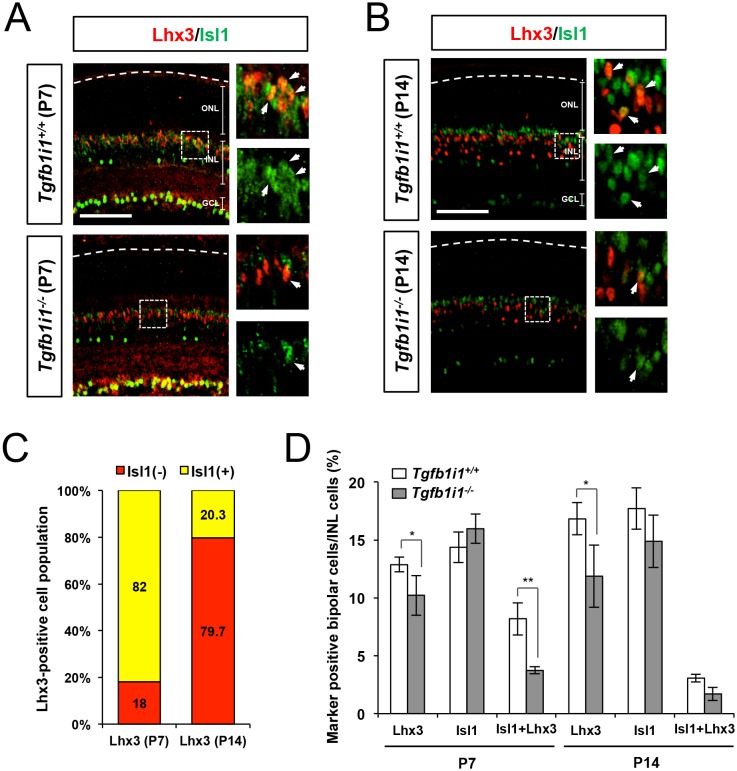
Distribution of Isl1- and Lhx3-expressing cells in Tgfb1i1+/+ and Tgfb1i1−/− mouse retinas.P7 (A) and P14 (B) Tgfb1i1+/+ and Tgfb1i1−/− littermate mouse retinas stained with a guinea pig anti-Isl1 antibody (green) and a rabbit anti-Lhx3 antibody (red). Images in the right columns are magnified versions of the dotted areas in the left columns. Scale bars, 100 μm. Isl1(-) (red) and Isl1(+) (yellow) cells among Lhx3(+) cells are shown in the graph in (C) and populations expressing each marker in total INL cells are shown in the graph in (D). Y-axis values in the graphs are averages and error bars indicate STD (n = 4, three independent litters). *p<0.05; **p<0.01.